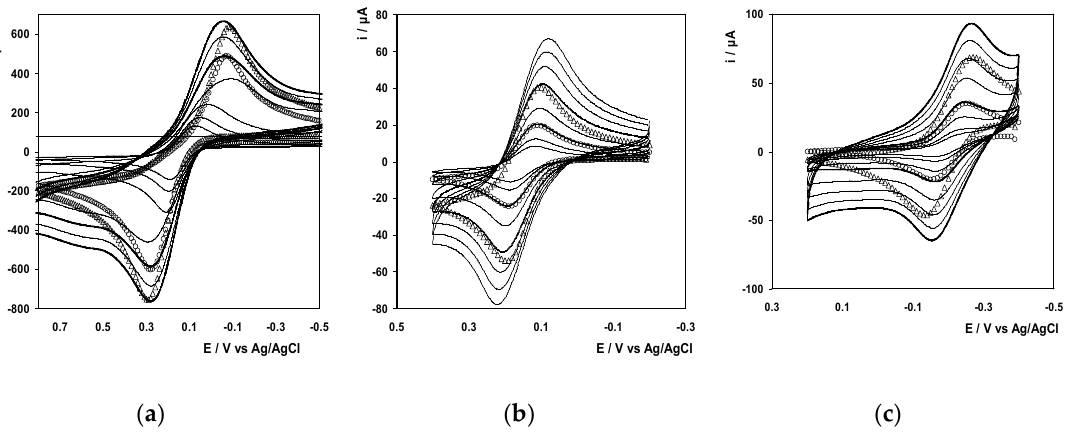
Figure 11. Cyclic voltammetry of 1 mM ( a ) ferri / ferro cyanide, ( b ) ferrocene methanol, and ( c ) ruthenium hexamine, in 0.1 M LiClO 4 at a gold-coated silicon wafer electrode functionalized with a